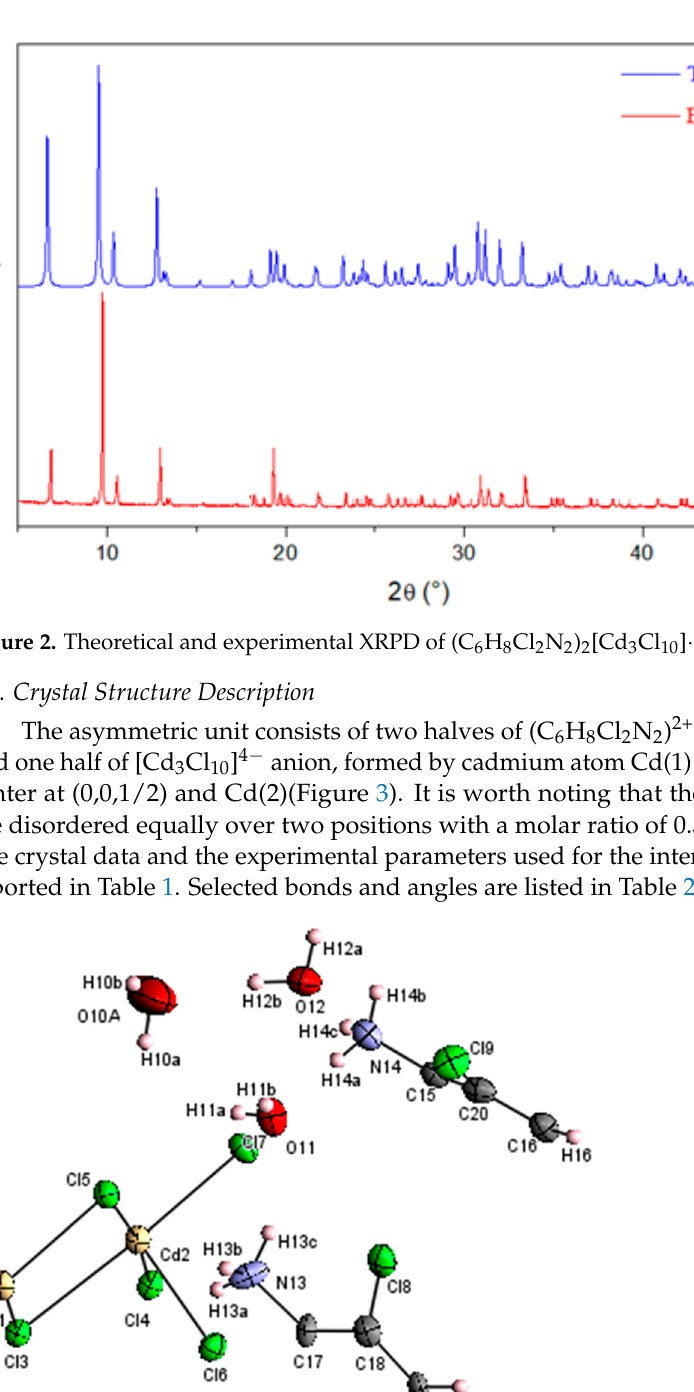
Figure 3. ORTEP representation of (C 6 H 8 Cl 2 N 2 ) 2 [Cd 3 Cl 10 ]·6H 2 O.